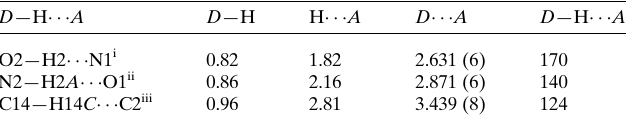
Table 2 Hydrogen-bond geometry (A˚ , (cid:5) ).